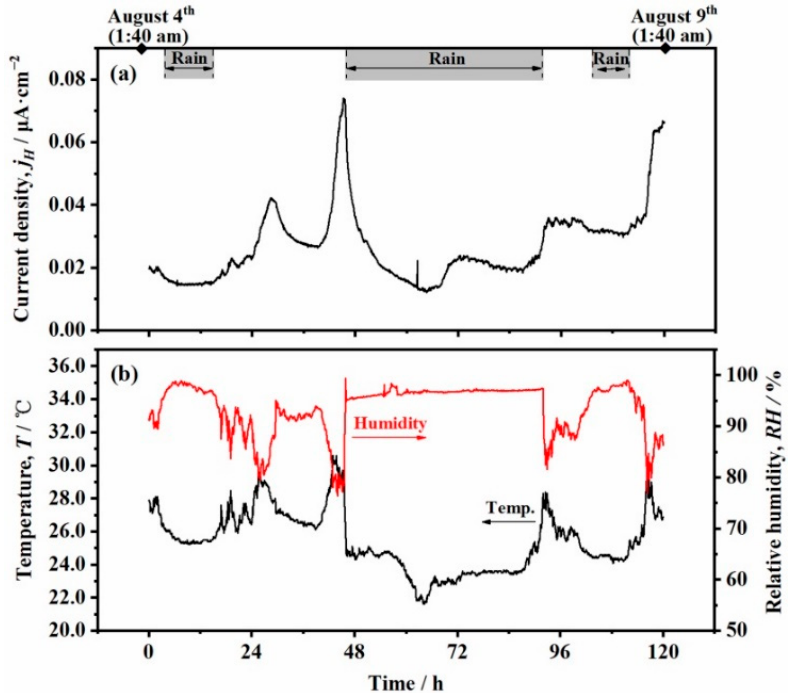
Figure 7. Time variations of the hydrogen permeation current density of the sensor exposed to the marine atmospheric zone ( a ), and temperature/relative humidity changes ( b ) from 4 August to 9 August during outdoor hydrogen permeation test.